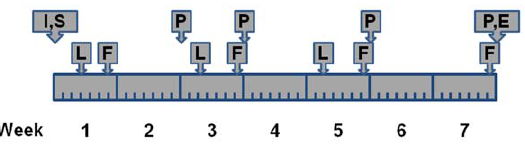
Figure 1. Illustration of schedule of experiment B. I=intraper- itoneal injection of FG-7142; S=electric shocks; L=light/dark test; F=freeze test; P=PIXImus scan; E=Euthanasia. The light/ dark test was conducted on day 3, and repeated every other week twice; the freeze test on day 6, and repeated every other week for three times; the PIMImus scan at week 2 and 3, and repeated every other week for two more times.